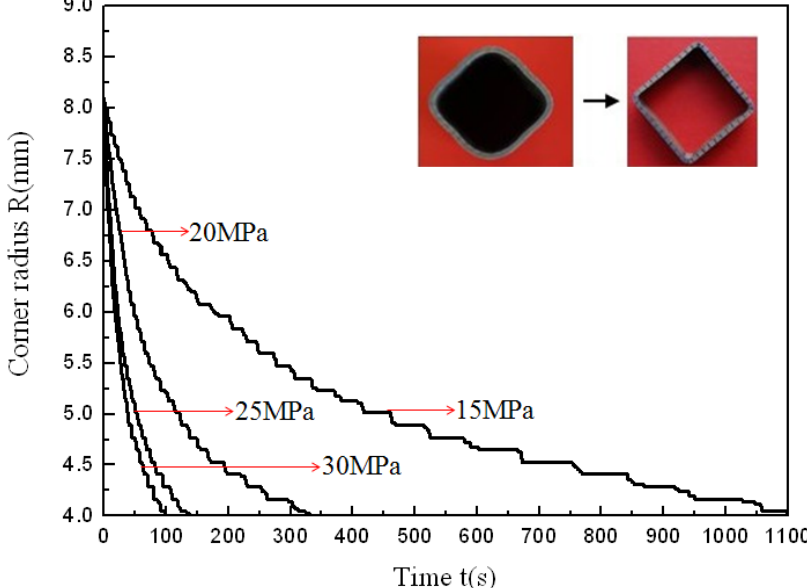
Figure 5. Corner filling process at 850 °C and four different pressure levels.